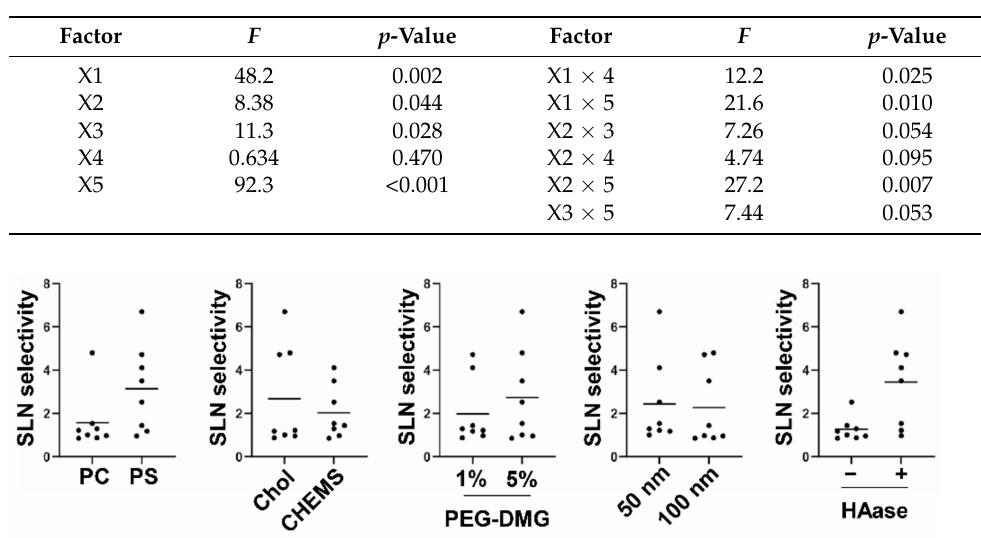
Table 3. Effect of each factor against SLN selectivity (ILN to ALN ratio).